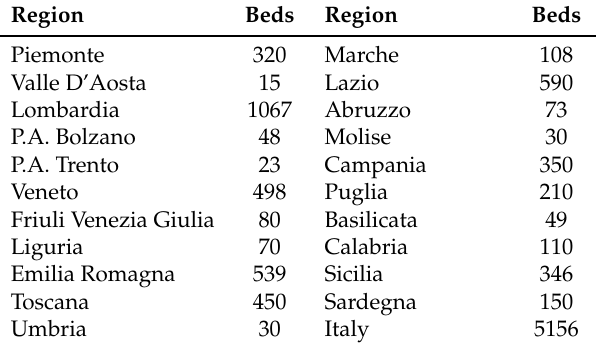
Table 1. Distribution of ICU beds in each region at the date of 15 March. Such data could increase in the future due to government investments for the